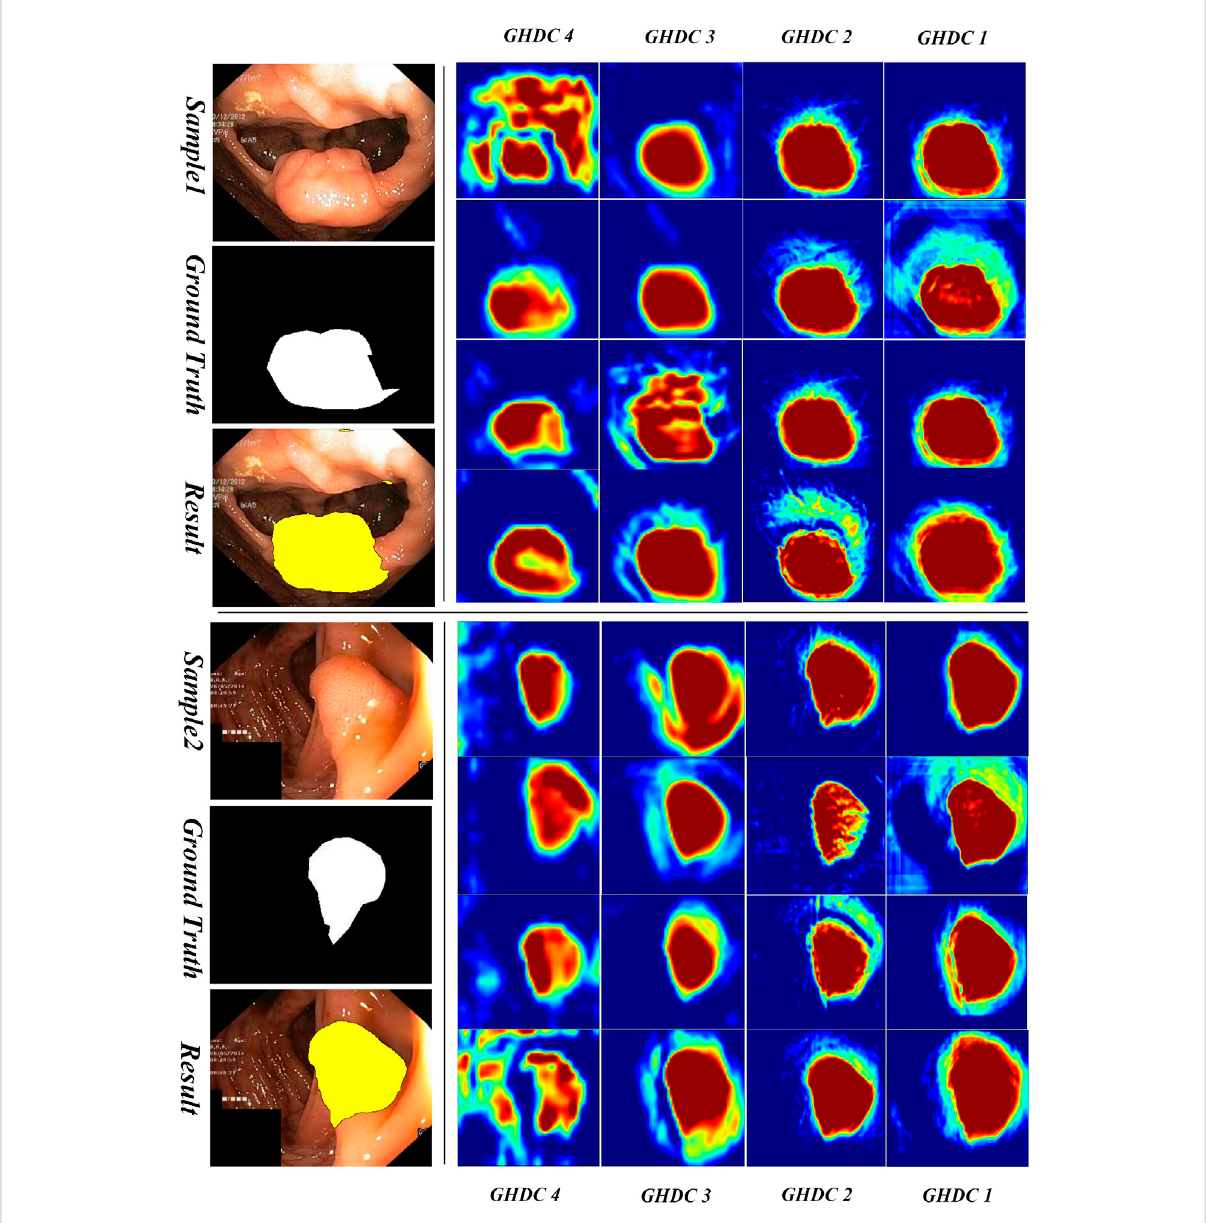
FIGURE 6 Visualization of the feature maps from the GHDC blocks on the Kvasir-SEG